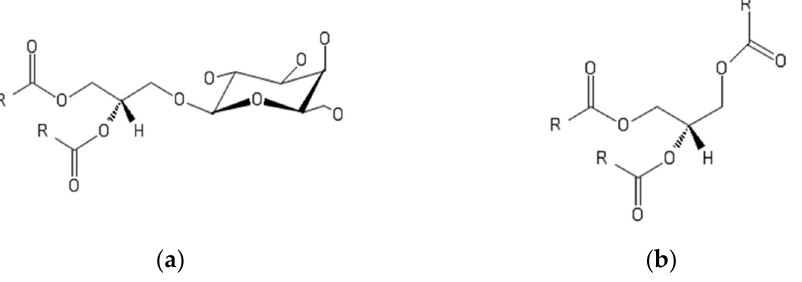
Figure 3. General structure of some glycolipids: ( a ) Chemical structure of a MGDG; ( b ) chemical structure of a DGDG.